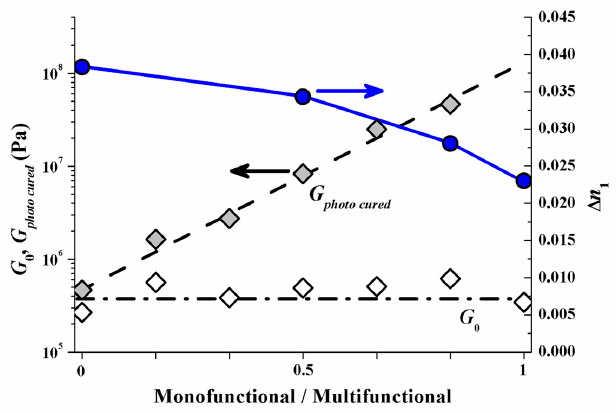
Figure 13. ∆ n 1 ( right y -axis, blue circles) and shear modulus G ( left y -axis), before (open squares) and after flood cure (grey squares), versus monomer mixing ratio (fraction of the multifunctional monomer increasing from 0 to 1) [51].